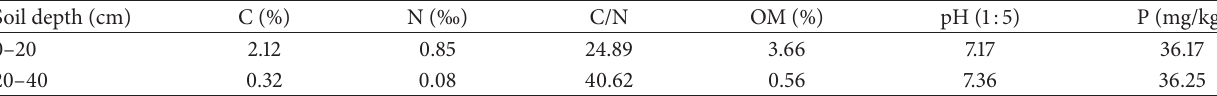
Table 1: Physicochemical characteristics of the plot study